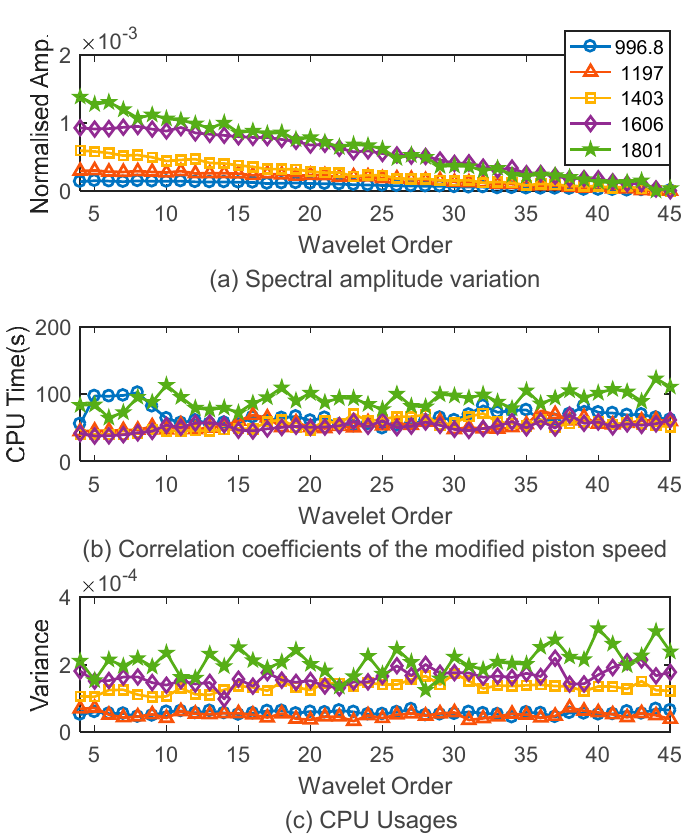
Figure 8. Optimal wavelet basis selection for diesel–10W30: ( a ) Spectral amplitude variation; ( b ) Correlation coefficients of the modified piston speed ; ( c ) Central processing unit (CPU) usages.